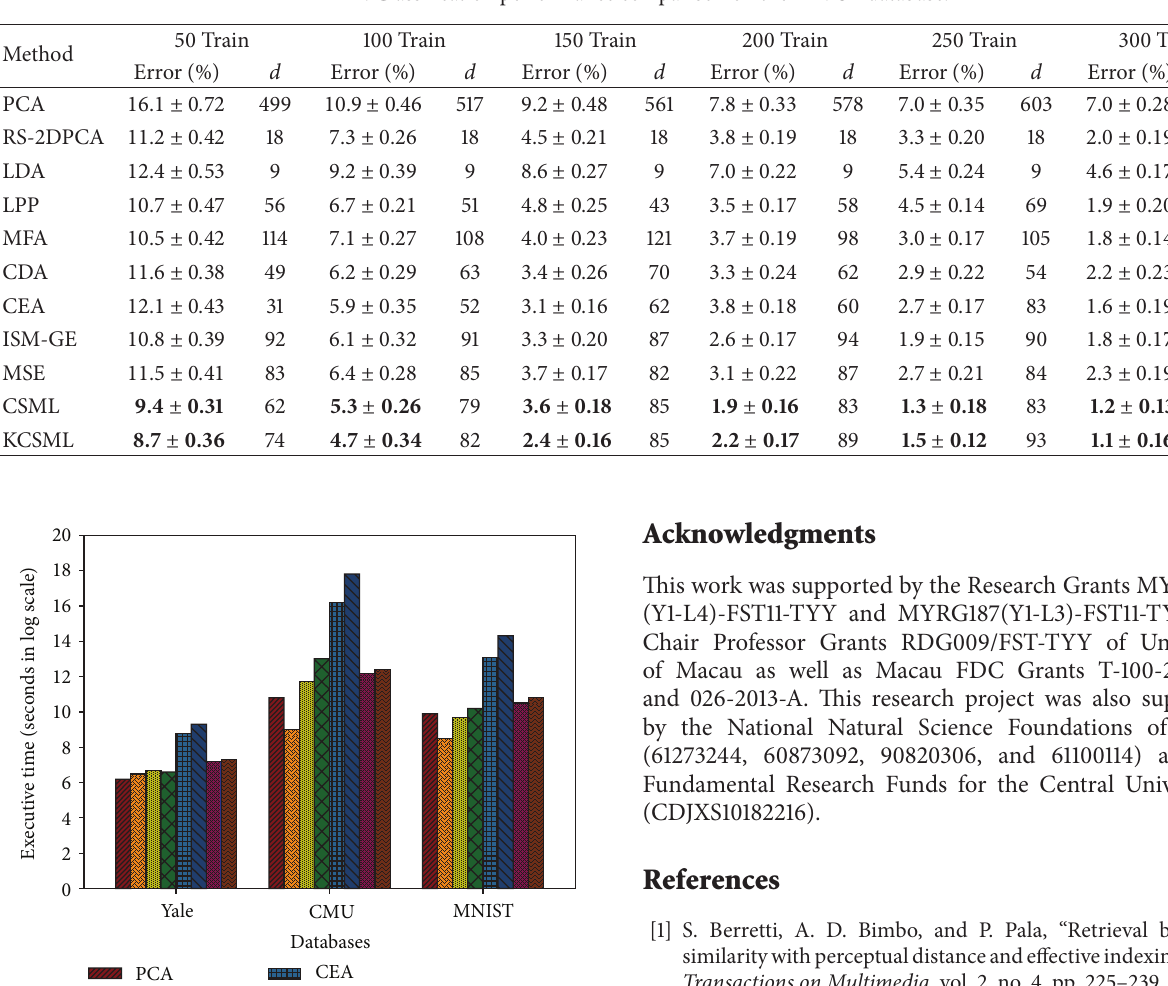
Table 4: Classification performance comparison on the MNIST database.